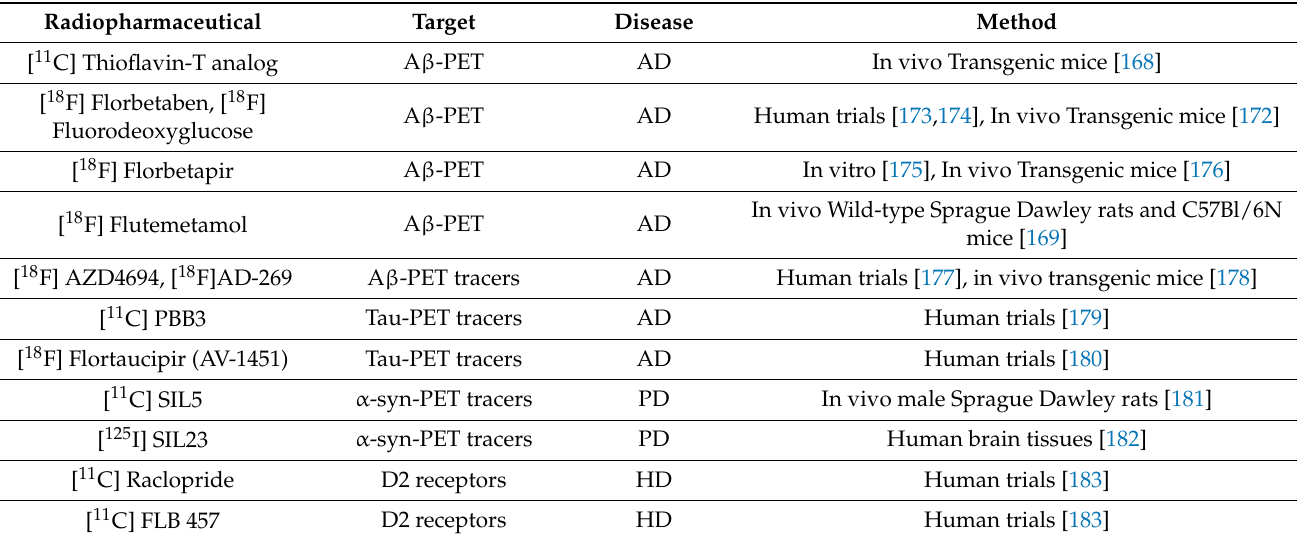
Table 5. Radiopharmaceuticals used in AD, PD, and HD